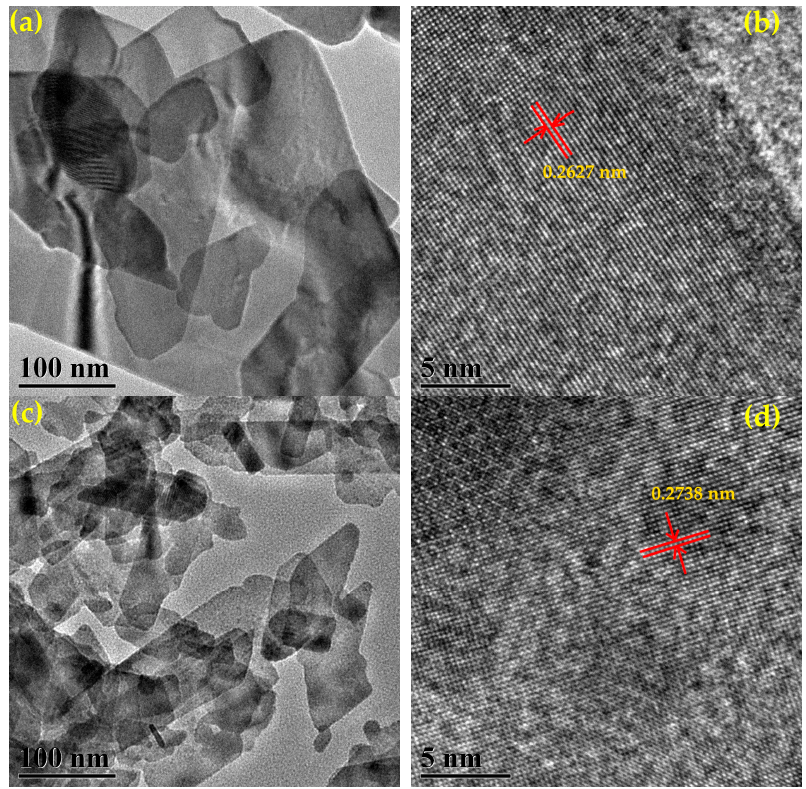
Figure 8. Transmission electron microscopy (TEM) and high resolution TEM (HRTEM) images of Bi 2 MoO 6 ( a , b ) and 1% S-doped Bi 2 MoO 6 ( c , d ).